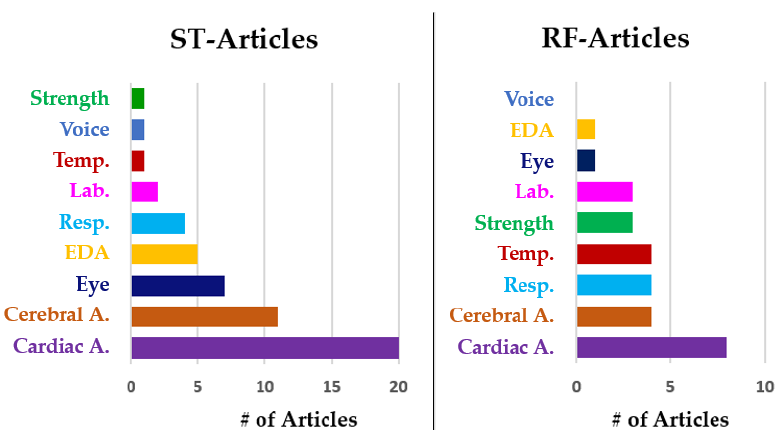
Figure 3. Objective measures employed in ST articles (with simulated flight task) and RF articles (real flight